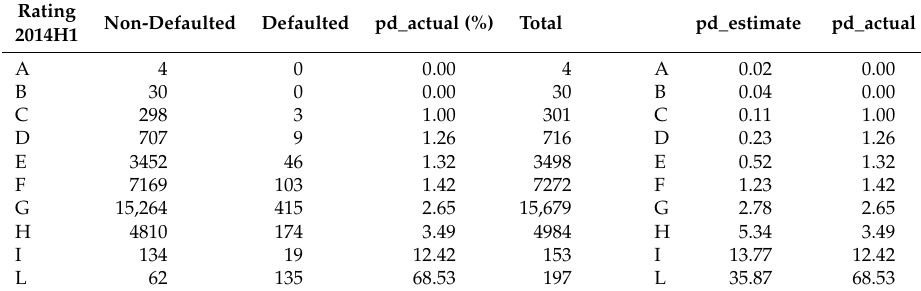
Table 8. The table indicates rating (column 1 and 6), amount of non-defaulted exposures (column 2), amount of defaulted loans (column 3), sample default frequency (column 4) and total loan amount in the first pool cut-off date. Column 7 reports the default probability derived from the logistic regression and column 8 reports the actual frequency of default and is equal to column 4. What we can observe is that the model is able to compute the cut-offs in a way that the default frequencies are monotone increasing from A-rated to L-rated. We report the statistics for the entire sample in Appendix A.